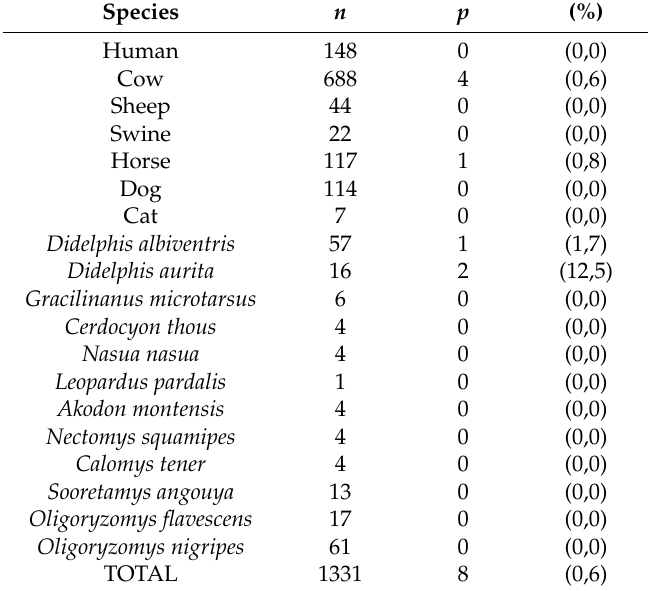
Table 1. Total of collected blood samples and PCR positivity among